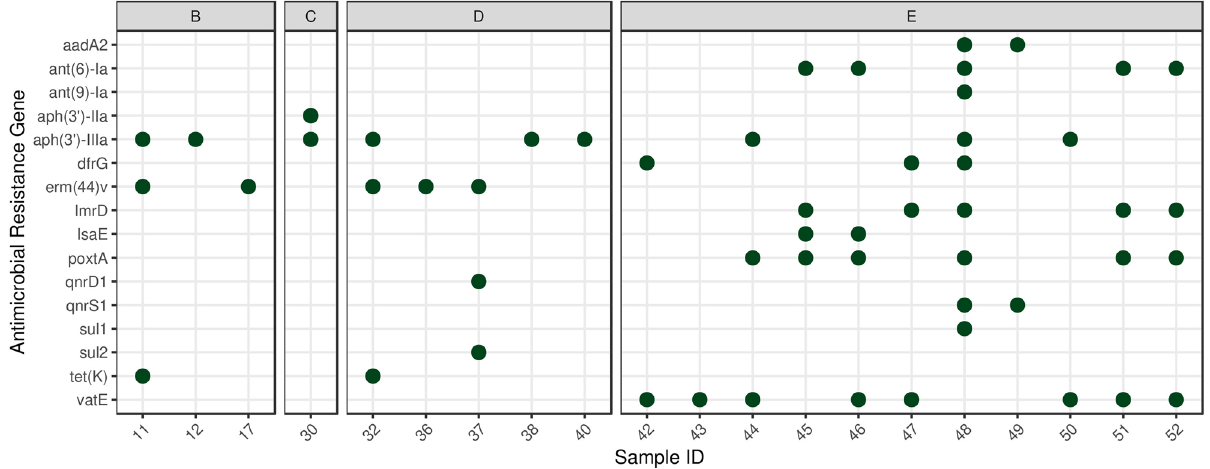
Figure 2. Identifed antimicrobial resistance genes (ARGs) by samples. Perfect ARG matches were plotted by samples. The data of the PRJNA495415 taken on days 0, 7, 14 and 28 were classified in groups A, B, C and D, respectively. All samples from BioProject PRJNA764355 were assigned to group E.